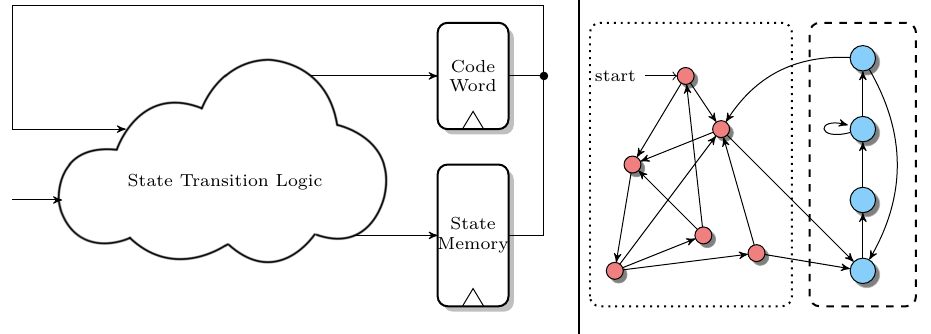
Figure 7: Interlocking Obfuscation design methodology example. The original FSM (dashed blue part) is augmented by an obfuscation mode and a code-word (dotted red